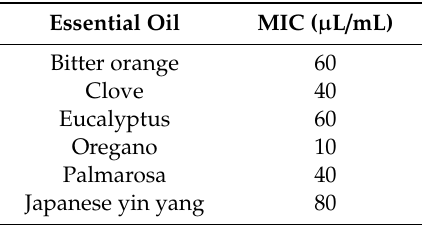
Table 3. Minimum inhibitory concentration values (in µ L / mL) of bitter orange, clove, eucalyptus, oregano, palmarosa and Japanese yin yang